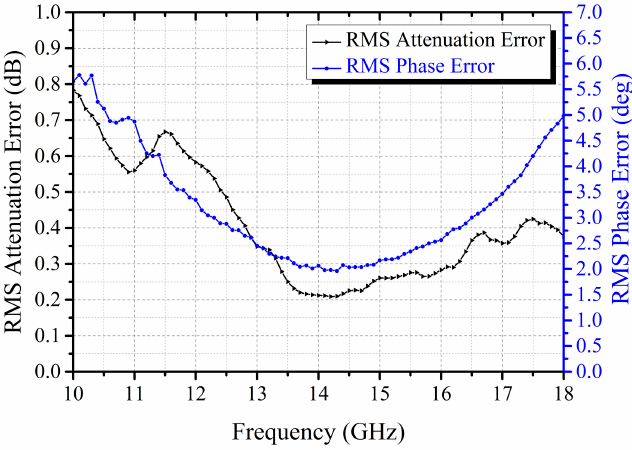
Figure 14. The measured RMS amplitude error and phase error of the proposed attenuator.